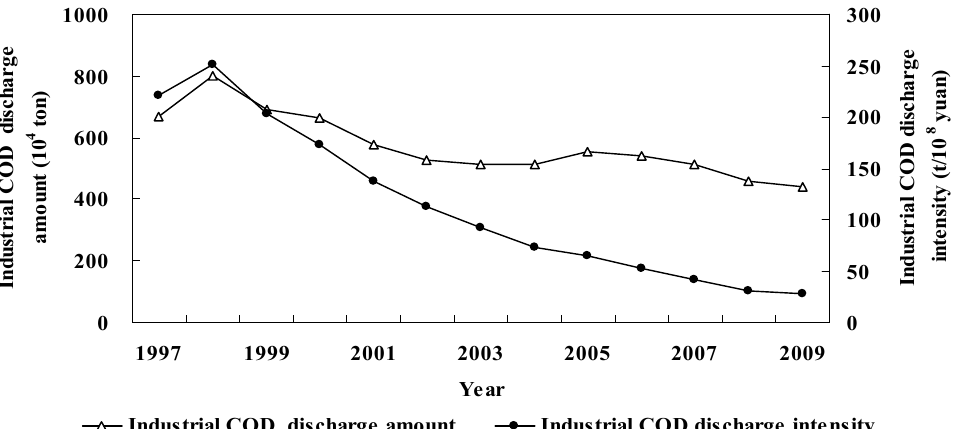
Figure 1. Industrial COD discharge amount and intensity from 1997 to